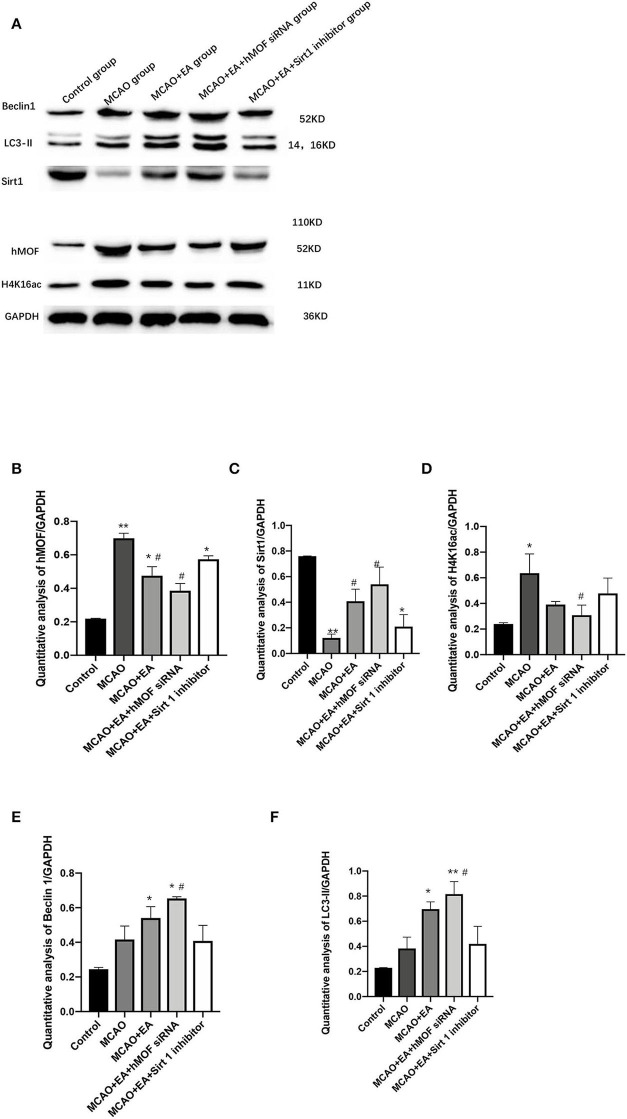
Electroacupuncture alters hMOF, Sirt1, H4K16ac, LC3-II, and Beclin1 expressions in the MCAO rat corpus striatum. (A) Western blot results of Sirt1, Beclin1, LC3-II, hMOF, H4K16ac, and GAPDH. (B) Quantification analysis of hMOF. Values are expressed as mean ± SEM (n = 6). *P < 0.05, **P < 0.01, vs. the control group; #P < 0.05, vs. the MCAO group. (C) Quantification analysis of Sirt1. Values are expressed as mean ± SEM (n = 6). *P < 0.05, **P < 0.01, vs. the control group; #P < 0.05, vs. the MCAO group. (D) Quantification analysis of H4K16ac. Values are expressed as mean ± SEM (n = 6). *P < 0.05, **P < 0.01, vs. the control group; #P < 0.05, vs. the MCAO group. (E) Quantification analysis of Beclin1. Values are expressed as mean ± SEM (n = 6). *P < 0.05, vs. the control group; #P < 0.05, vs. the MCAO group. (F) Quantification analysis of LC3-II values are expressed as mean ± SEM (n = 6). *P < 0.05, **P < 0.01, vs. the control group; #P < 0.05, ##P < 0.01, vs. the MCAO group.